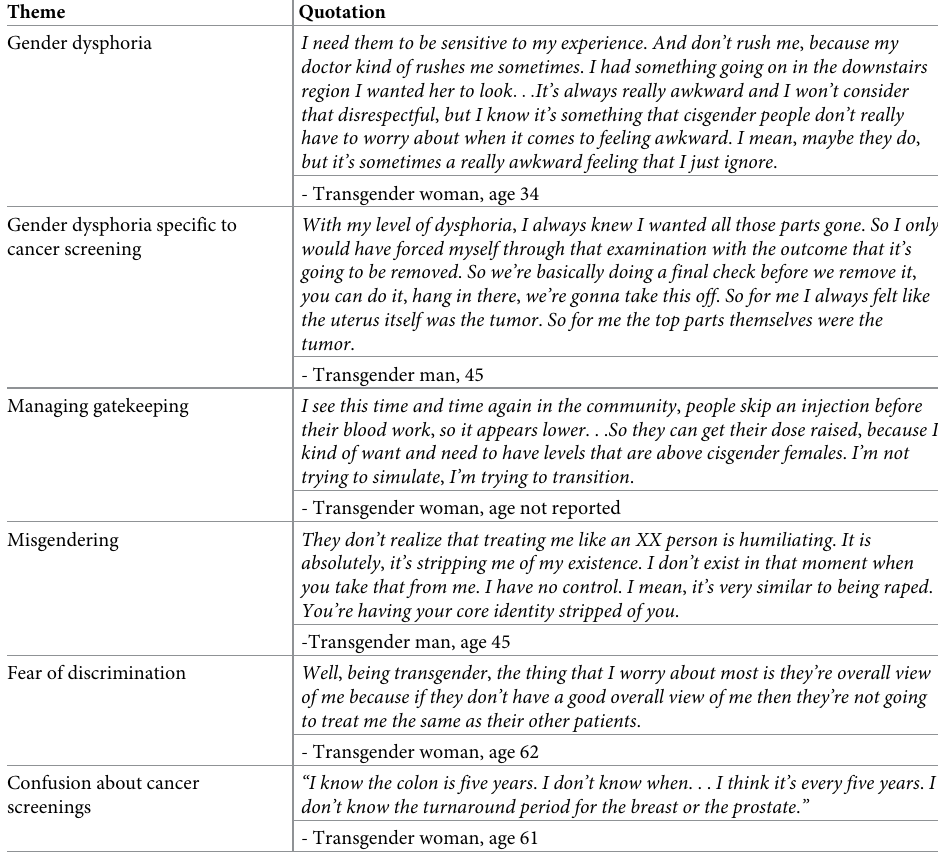
Table 3. Unique experiences due to being transgender or gender